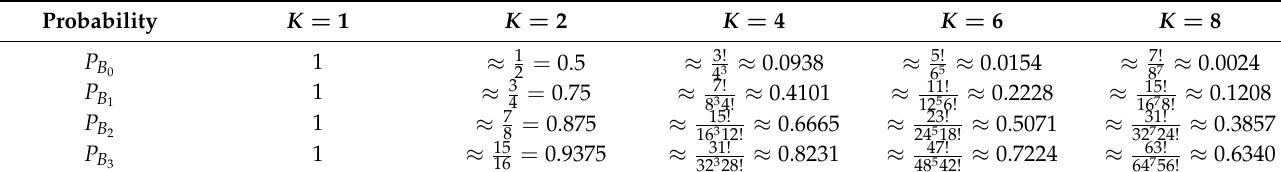
, P B , P B , P B of different K in the case of B from K to 8 K 0 2 3 1